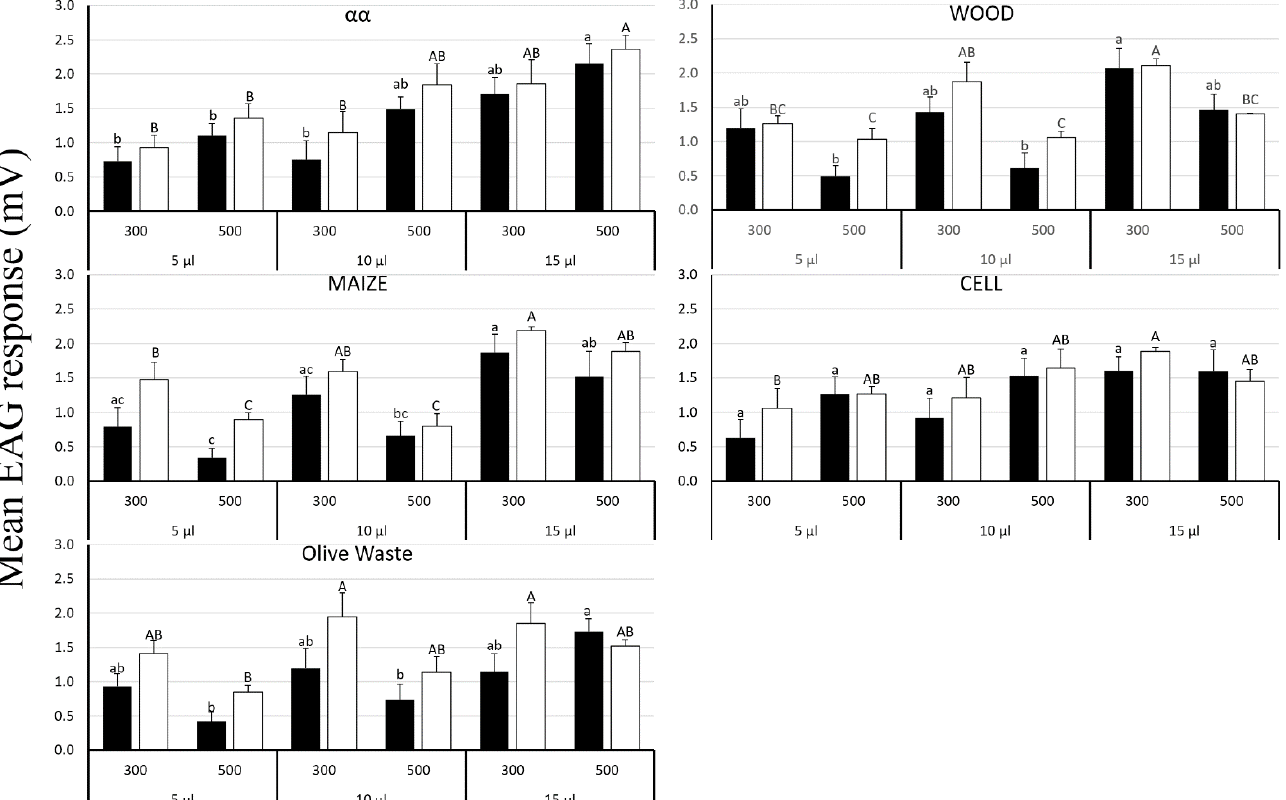
Figure 4. Mean EAG response (mV) recorded with female (black) and male (white) of two-week-old OLF to application of 5 µL, 10 µL or 15 µL SW as stimuli. Abbreviations as indicated in Figure 1. Different letters mean significance (ANOVA test, Post-hoc Student–Newman–Keuls test). Uppercase and lowercase letters refer to males and females, respectively.